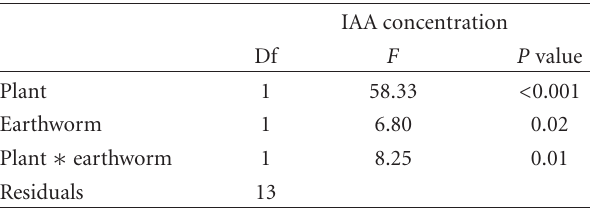
Table 1: Impact of the factors “plant,” “earthworm,” and their interaction on IAA production by cultivable